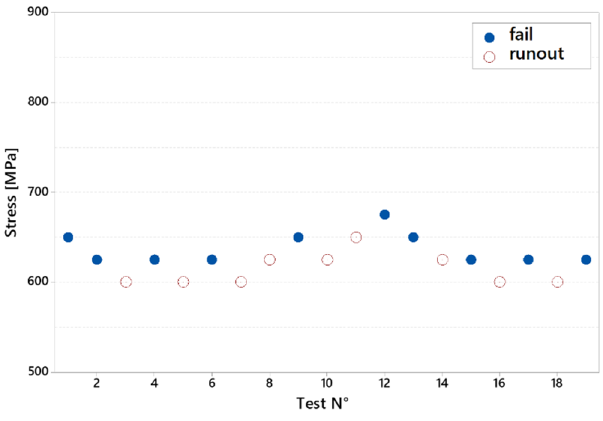
Figure 6. Complete staircase results of untreated specimens. Table 6. Stress and cycles by each test of the staircase of the untreated specimens.